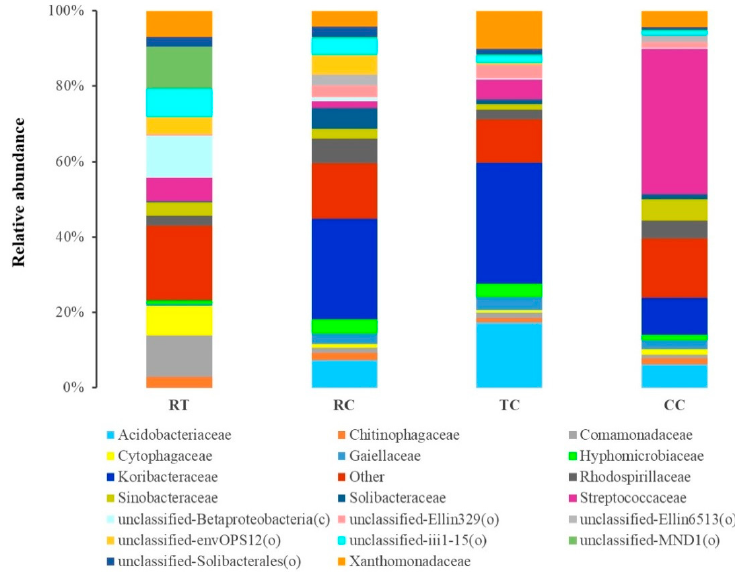
Figure 2. Composition of the top 20 families under four cropping